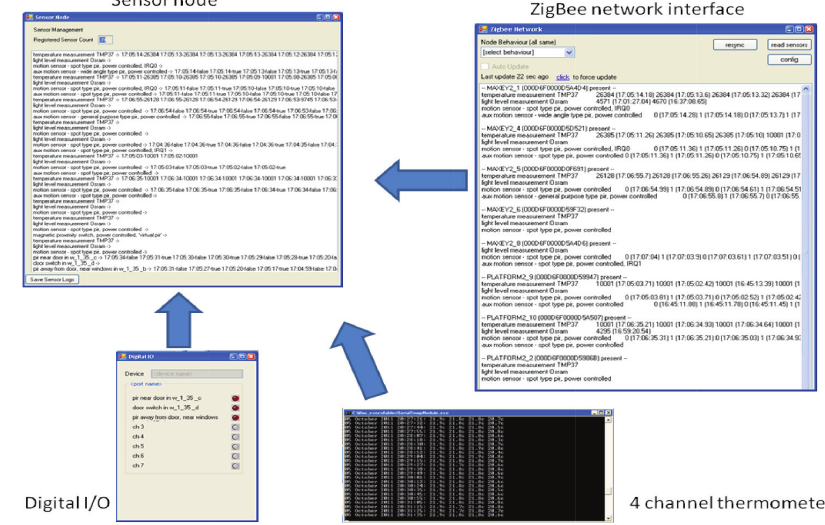
Fig. 5. some system infrastructure executables